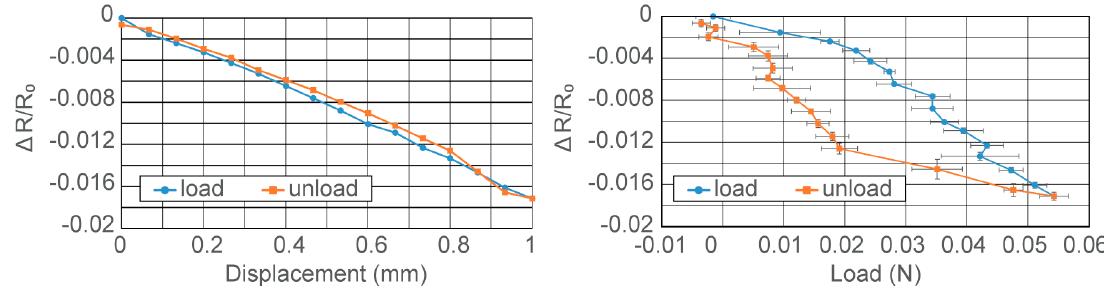
Figure 7. Results for the sensitivity tests. ( a ) Change of resistance as compared to displacement of center pole during load application, and ( b ) change of resistance as compared to the applied load.